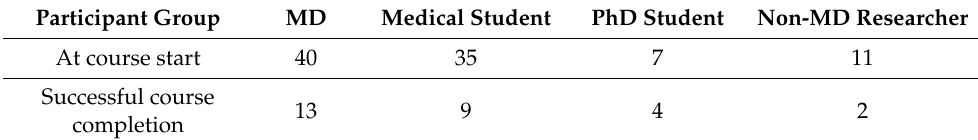
Table 1. A list of the course participants according to group before and after the course.